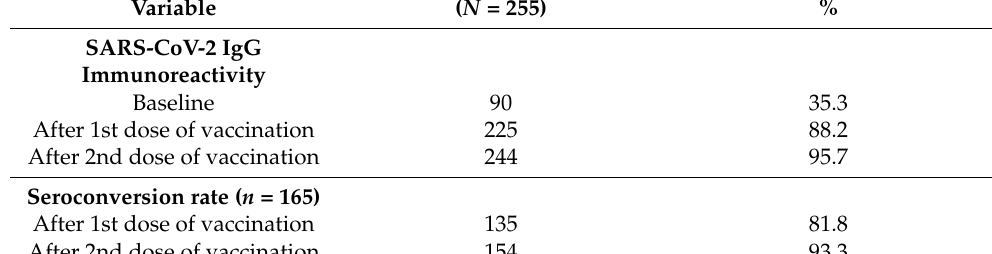
Table 3. Immunoreactivity and seroconversion rate at different time points of the study.